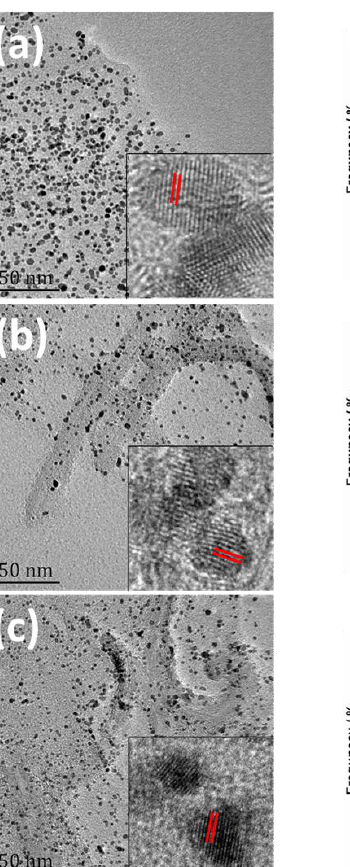
Figure 2. FESEM images for G-M ( a , b ); TEM image of G-M ( c ); XRD patterns of GO, G, G-M, and N-G-M ( d ); N 2 adsorption–desorption isotherms of G, G-M, and N-G-M supports ( e ); Raman spectra of MWCNT, G, G-M, and N-G-M supports ( f ).